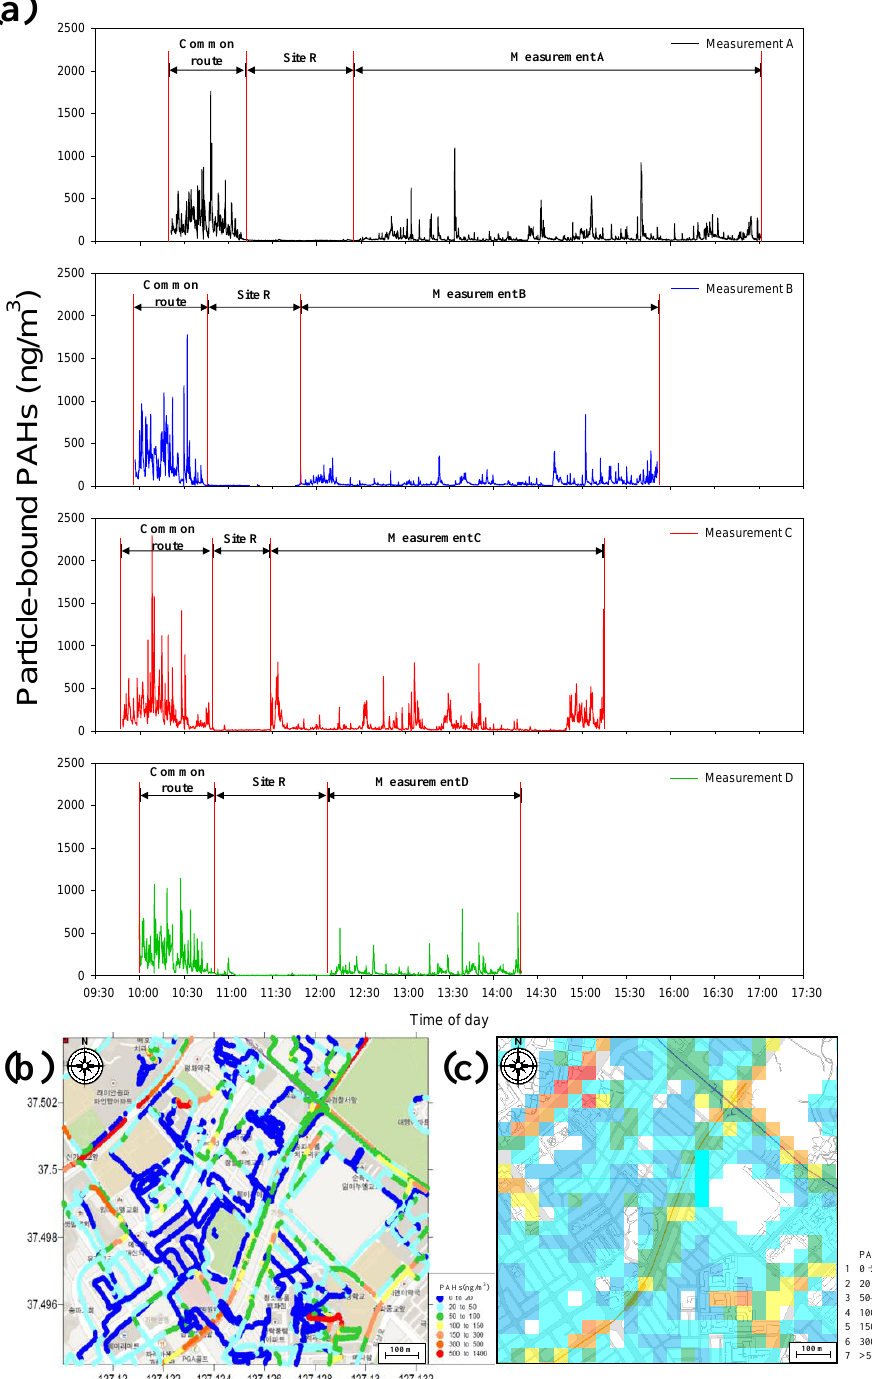
Figure 3. ( a ) Processing of a time-series data, ( b ) line map, and ( c ) 2-D map for pP